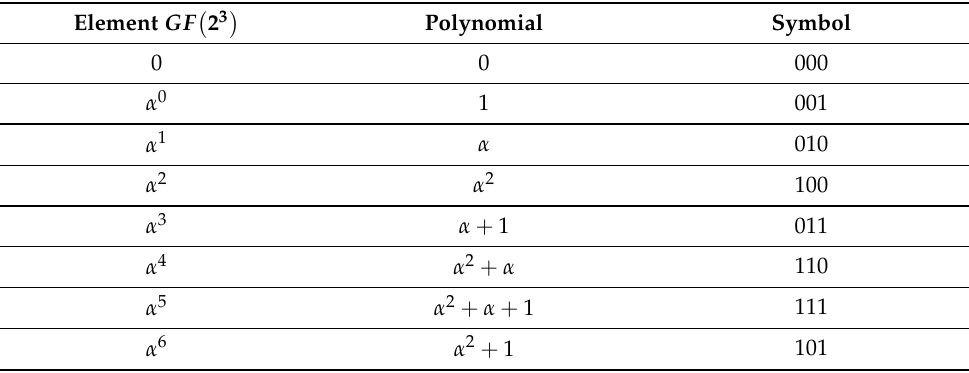
Table 3. Generation of the polynomials from P ( x ) = x 3 + x + 1. (cid:0) (cid:1) Polynomial Element GF 2 3